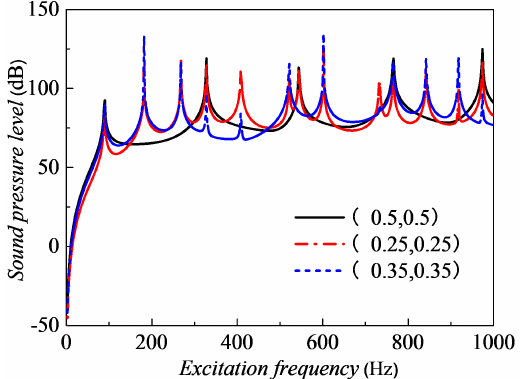
Figure 15: Sound pressure level of plate with different location of point force